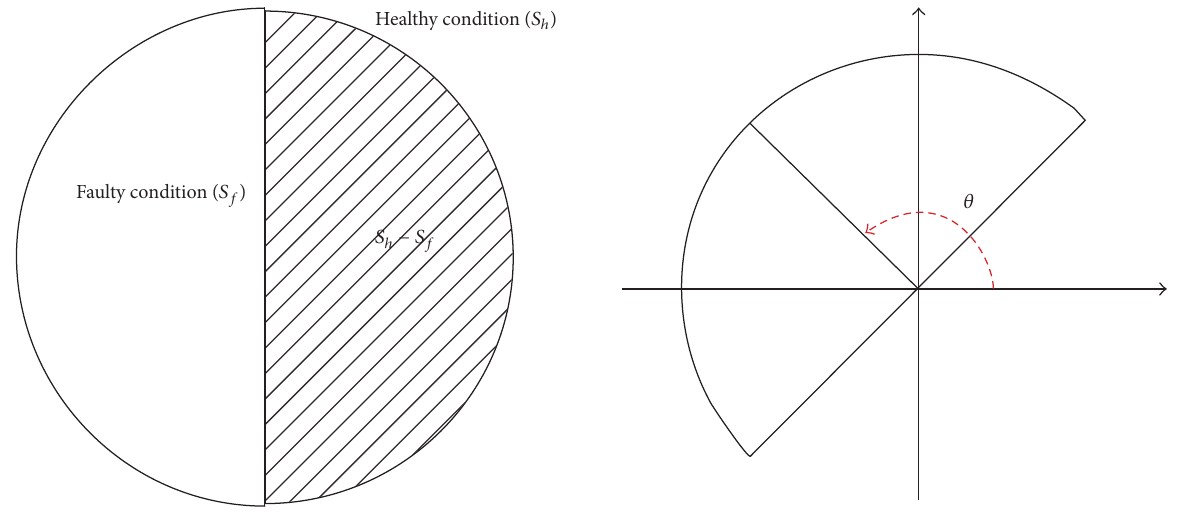
Figure 4: Definition of 𝐸 𝑠 and 𝐼 𝜃